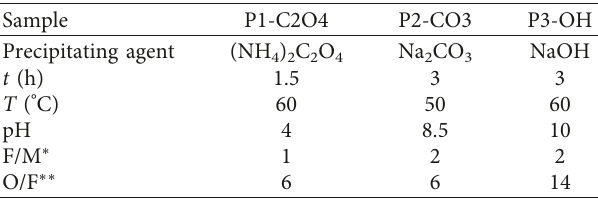
∗ Total amount of citric acid (the fuel “F”) to metal ions (M) in the molar ratio F/M. ∗∗ Amount of oxidant (O) to citric acid (the fuel “F”) in the molar ratio